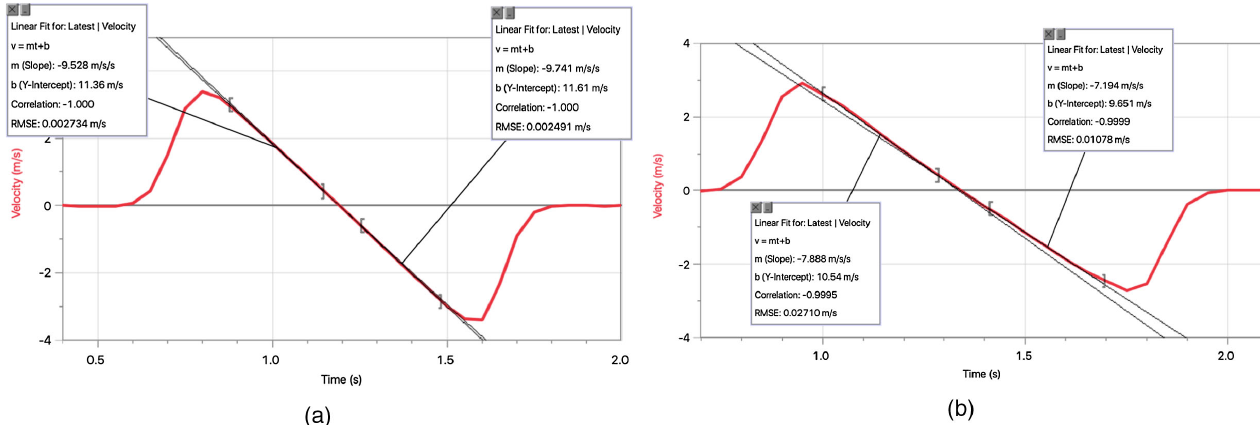
FIG. 2. Sample velocity data from (a) a basketball and (b) a beach ball, thrown upwards. Students use the linear fit function in LoggerPro to measure the acceleration while the ball is moving up (positive velocity on graph) and down (negative velocity on graph). For the basketball, the acceleration is approximately constant during the entire trajectory, as shown by the approximately parallel linear fit lines for the upwards and downwards trajectories on the velocity graph. The magnitude of acceleration during the entire trajectory is close to the expected value for g . For the beach ball, the students find that the acceleration of the measured acceleration is slightly less on the way down, an effect caused by the drag